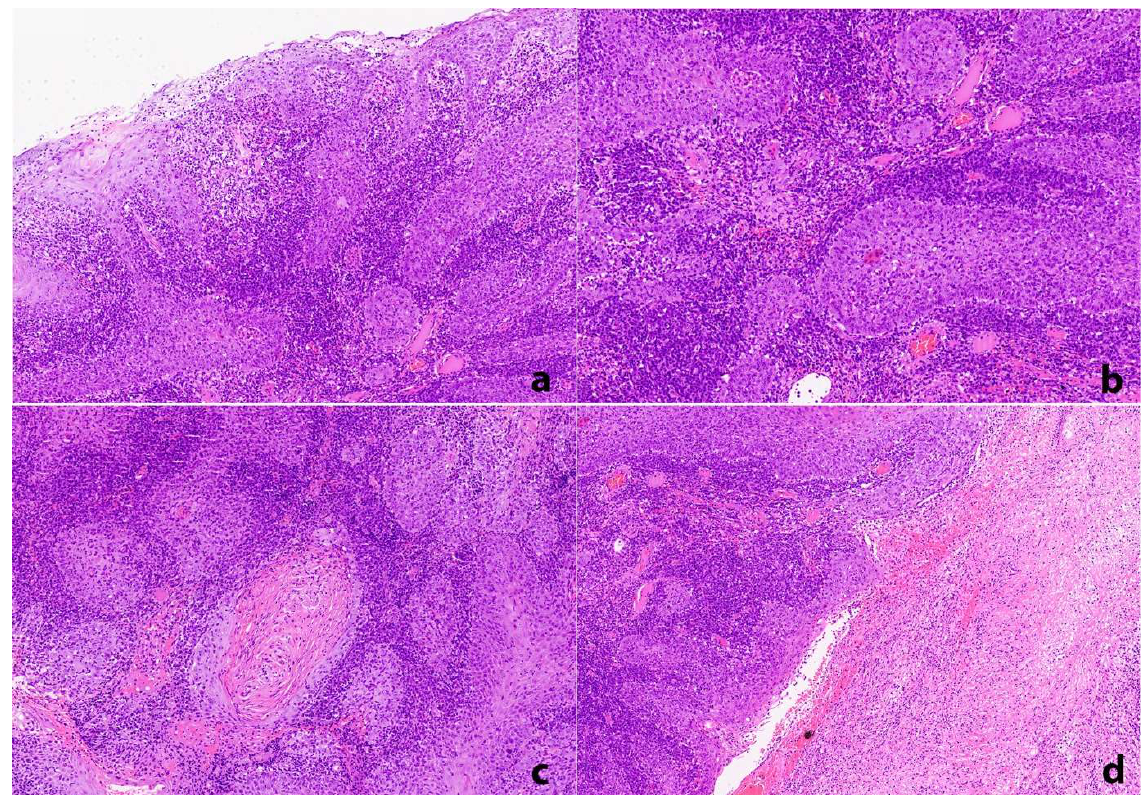
Figure 3. Histopathologic examination (Hematoxylin and Eosin, initial magnification 200x) : ( a ) diffuse infiltration of the underlying connective tissue by neoplastic cells arising from a partially ulcerated and non-keratinized stratified squamous epithelium, ( b ) diffuse dense lymphoplasmacytic cell infiltrate surrounding the neoplastic epithelial cells and obscuring the tumor islands, ( c ) focal keratin pearl formation, and ( d ) focal areas of tissue necrosis.